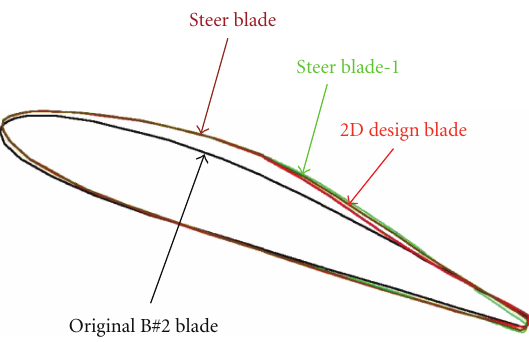
Figure 15: Blade shape obtained from 2D blade